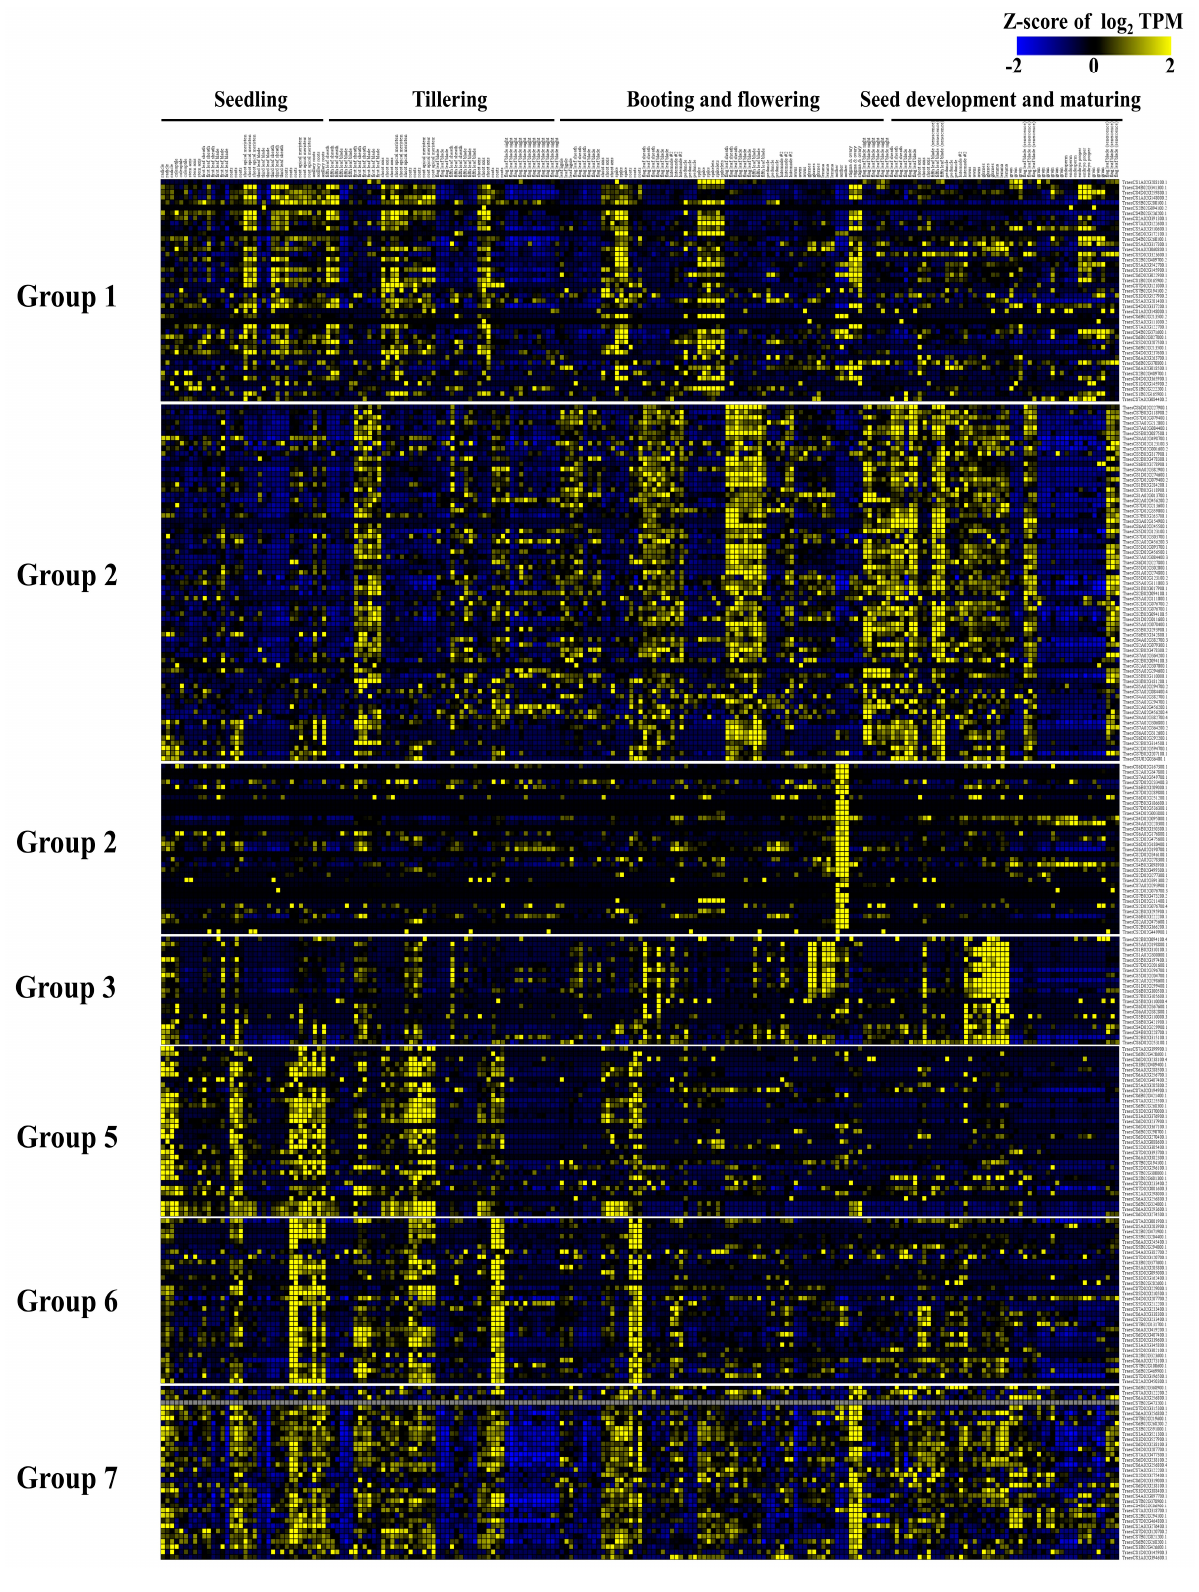
Figure 7. Expression profiling and classification of wheat U-box E3 genes in developmental stages. The average log 2 transformed transcripts per million (TPM) values of U-box E3 genes at different tissue and developmental stages of RNA − sequencing samples representing 22 tissue types, from grain, root, leaf, and spike samples across multiple time points, were classified into seven sub − groups by K − means clustering method.